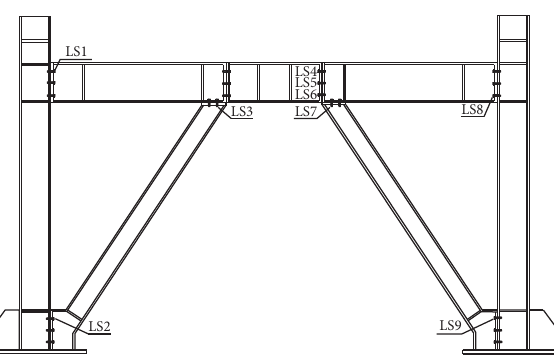
Figure 25: Number of bolts in